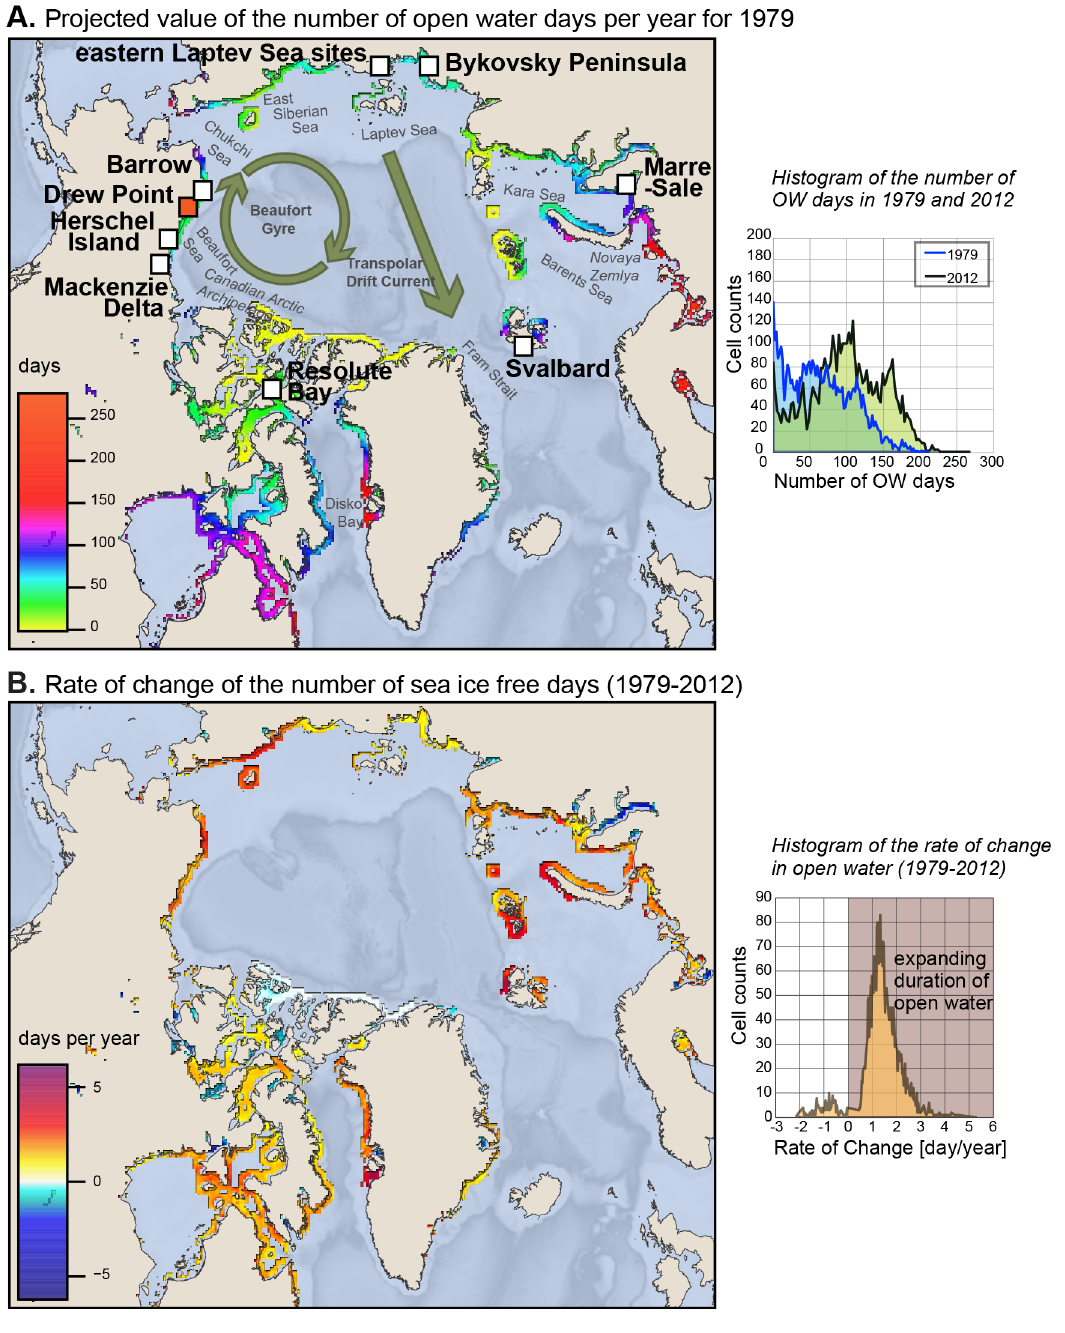
Figure 1. Maps of sea-ice change for coastal cells across the whole Arctic. We calculated the number of open-water days per year – defined as sea-ice concentration less than 15% – for the period 1979–2012 for each nearshore cell in which sea ice is shore fast (sea ice present for more than 60 days) for at least 20 years. We fit a linear trend line to number of open-water days. (a) The value of the trend line constraining the projected number of open-water days in 1979. The inset histogram shows the distribution of the number of open-water days in 1979 and 2012. (b) The resulting rate of change in the number of open-water days per year (slope of the trend line). Only cells with p values of less than 0.05 are shown. Typical rates on the Beaufort Sea coast of Alaska are 1.5–2.5dayyr − 1 . Inset histogram shows the distribution of the rate of change. Underlying bathymetry from The GEBCO 08 Grid (version 20100927, http://gebco.net).